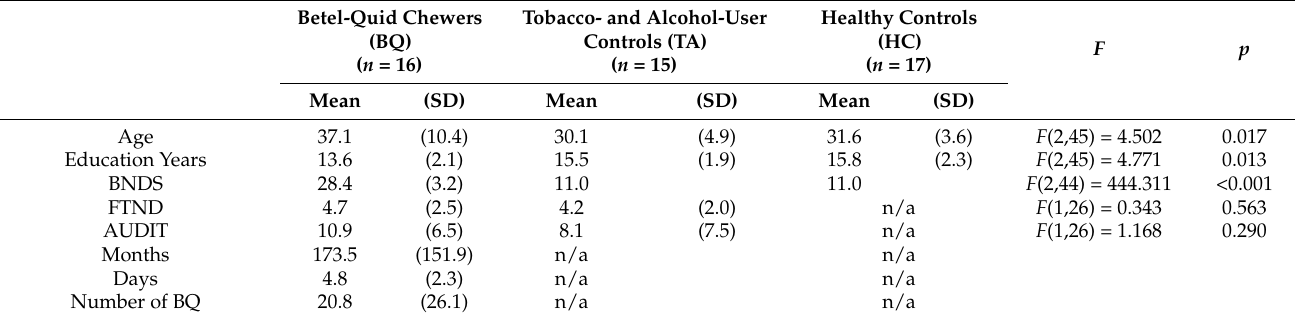
Table 1. Demographic and clinical characteristics. Standard deviations are in parentheses.